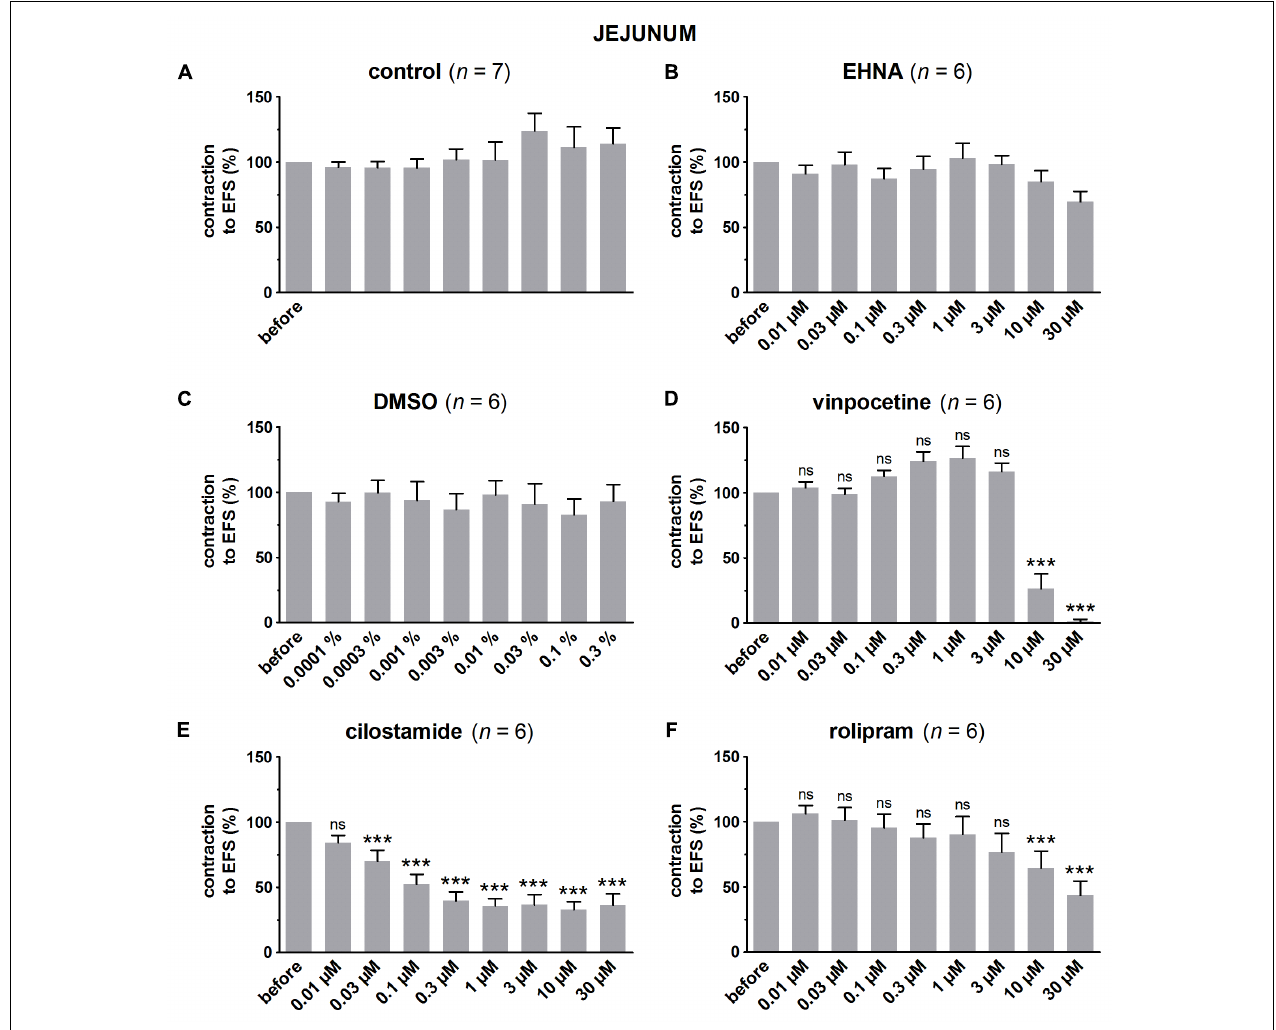
FIGURE 6 | Influence of increasing concentrations (0.01–30 µ M) of the PDE inhibitors EHNA (B) , vinpocetine (D) , cilostamide (E) and rolipram (F) , and the solvent DMSO (C) on submaximal electrically induced cholinergic contractions at V 50% (10 s trains at 8 Hz, 0.5 ms, interval of 10 min) in murine jejunum circular smooth muscle strips. Parallel time controls not receiving PDE inhibitor or solvent are shown in (A) . Three contractions were induced in the presence of each concentration of the PDE inhibitor and every 3 rd contraction is shown, expressed as percentage of the mean of the five contractions before addition of the PDE inhibitor. Experiments were performed in the continuous presence of 4 µ M guanethidine and 300 µ M L-NAME. Means ± SEM; ns not significant, ∗∗∗ P < 0.001 versus reference before (repeated measures ANOVA with Bonferroni corrected t -test). For control, EHNA, and DMSO, the repeated measures ANOVA was not